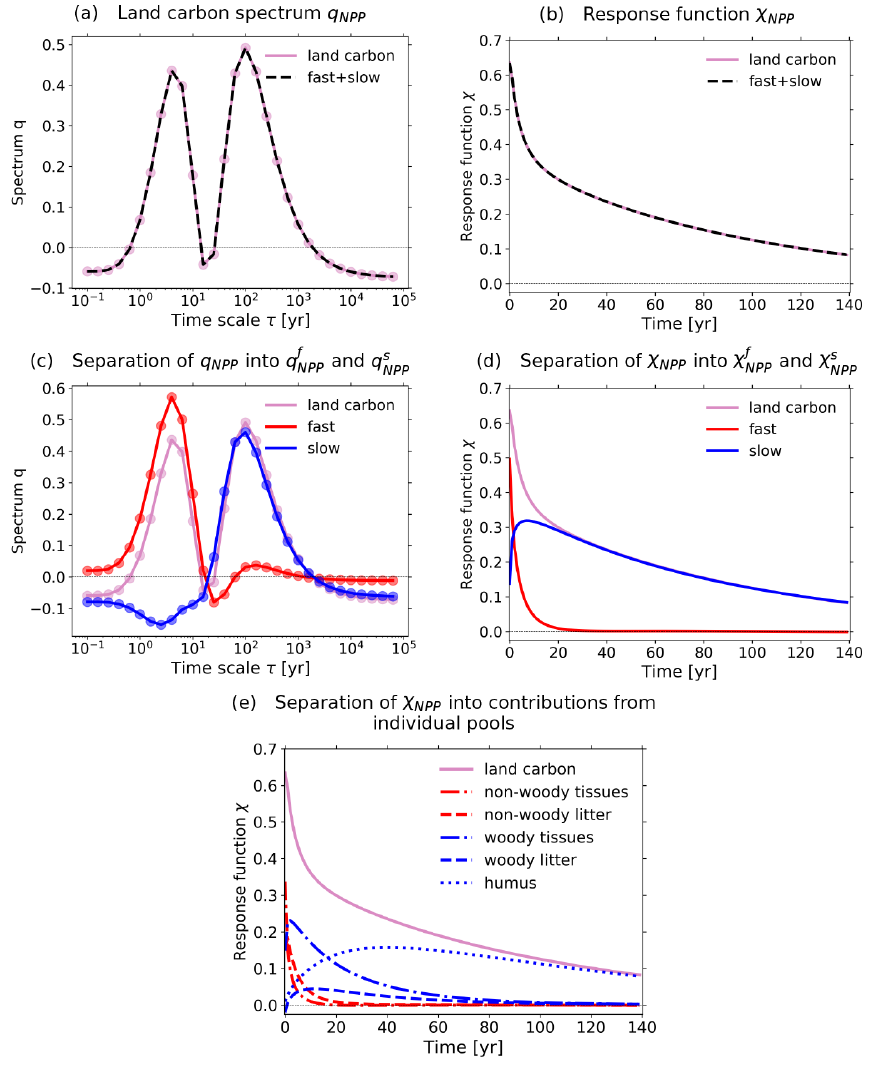
Figure 12. Investigation of the contribution from the pools with fast dynamics (non-woody pools) and those with slow dynamics (woody and humus pools) to the land carbon spectrum. The analysis is based on the 2 × CO 2 bgc experiment. (a) Land carbon spectrum q NPP and its reconstruction via Eq. (35) from the fast and slow components; (b) response function χ NPP and its reconstruction via Eq. (34) from the response functions for the fast and slow components; (c) separation of spectrum q NPP into q f function χ NPP into χ f and χ s ; (e) separation of χ NPP into contributions from the individual pools. For more details, see the NPP NPP